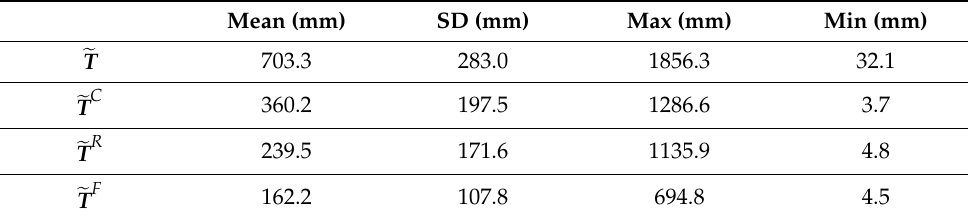
C R F , (cid:101) T and (cid:101) T in the square path.